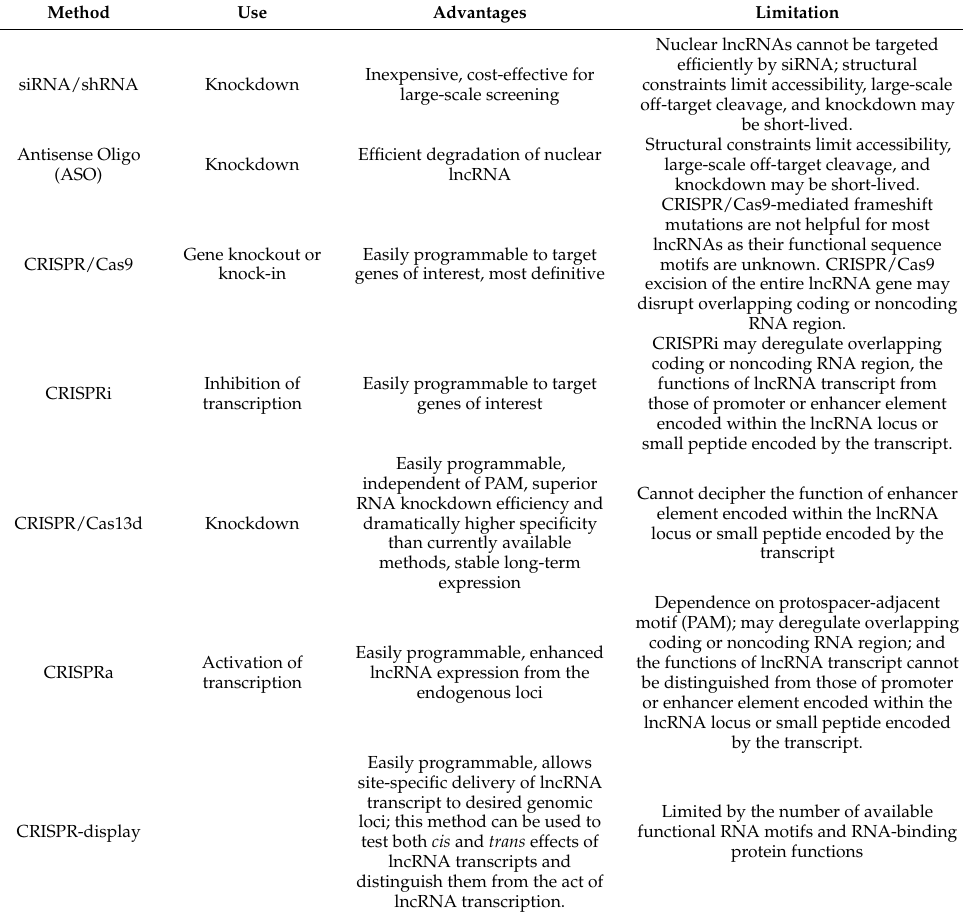
Table 2. Methods to modulate lncRNA expression for functional